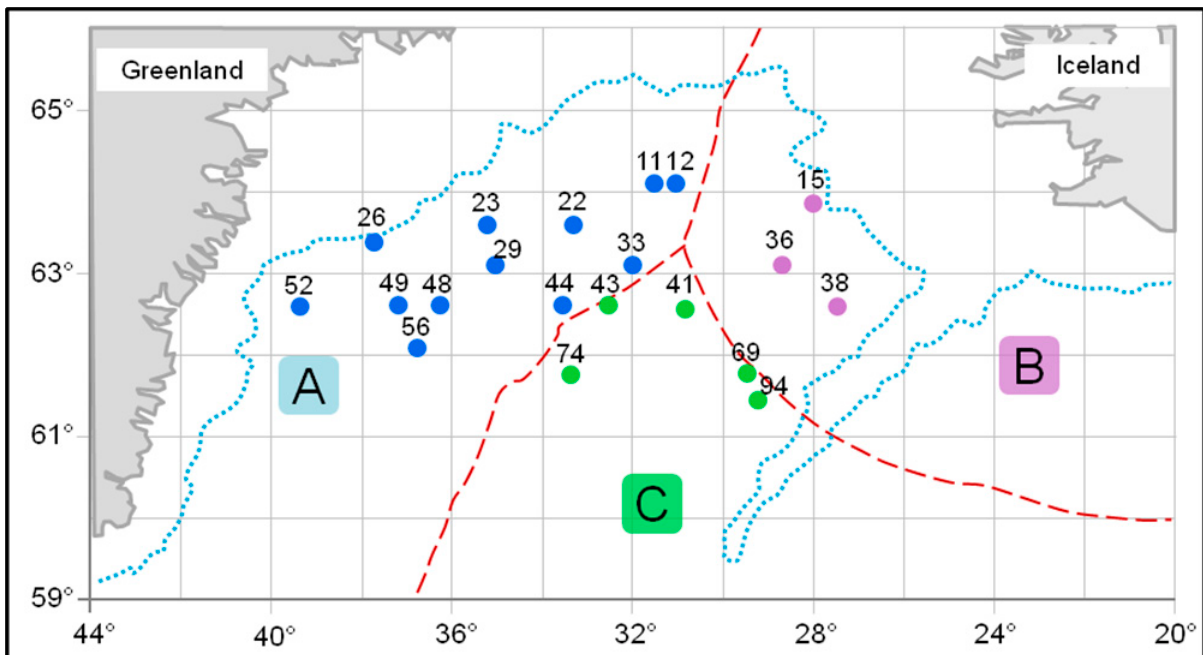
Figure 1. Schematic map of the collection of the beaked redfish, Sebastes mentella, in the Irminger Sea (North Atlantic). Legend: A—Greenland fishing zone; B—Iceland’s exclusive economic zone; C—NEAFC regulation area; points—trawl numbers.